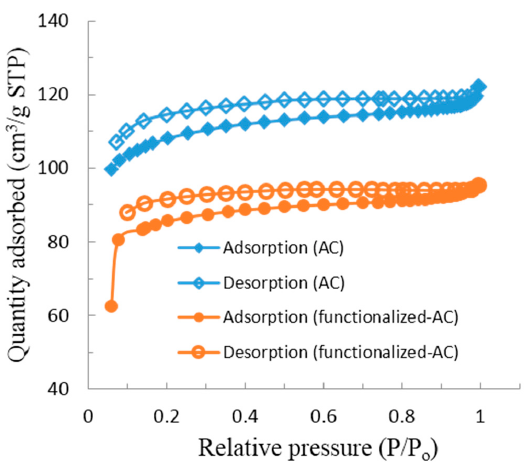
Figure 2. Nitrogen adsorption–desorption isotherm of AC and functionalized-AC.